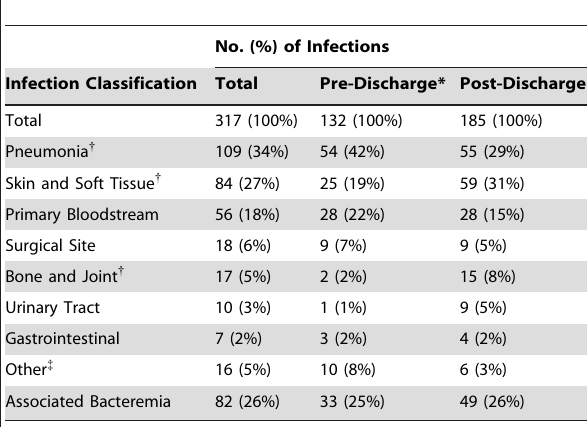
* Include infections occurring among outpatients at the time of new detection. { Differed significantly (p , 0.05) between pre- and post-discharge infections using chi-square test. { Includes 6 eye ear, nose, and throat infections, 6 lower respiratory tract infections, 3 cardiovascular system infections, and 1 central nervous system infection.